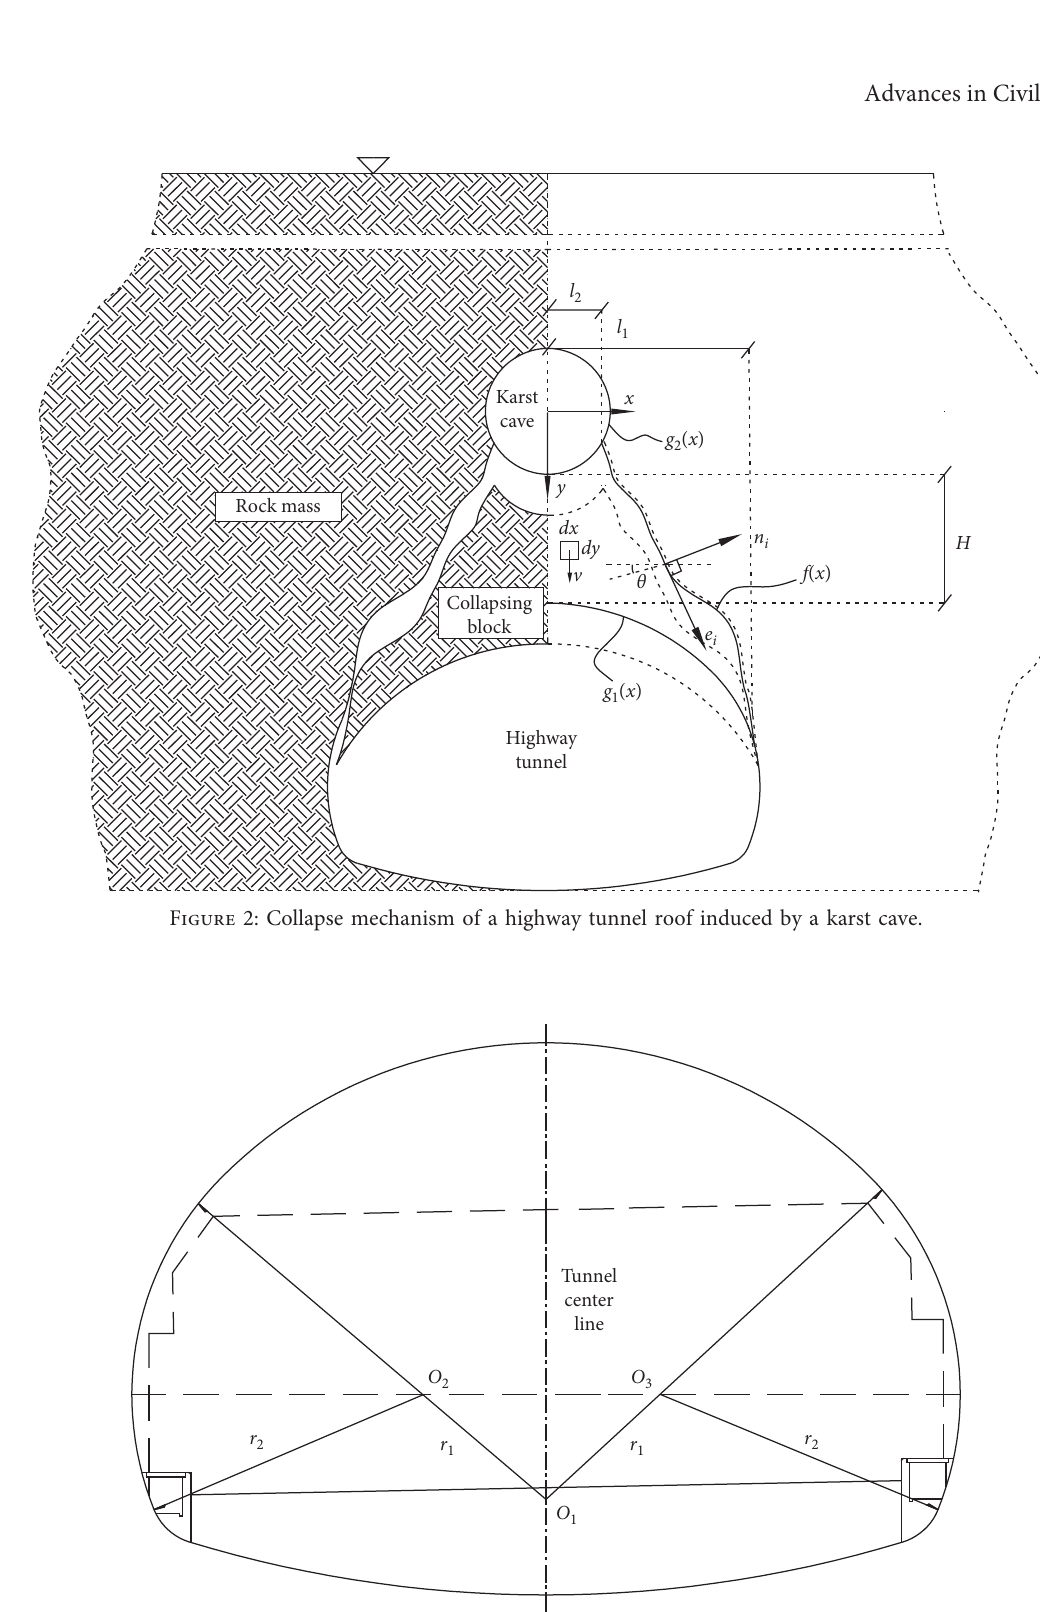
Figure 3: Standard internal contours and construction clearance of a highway